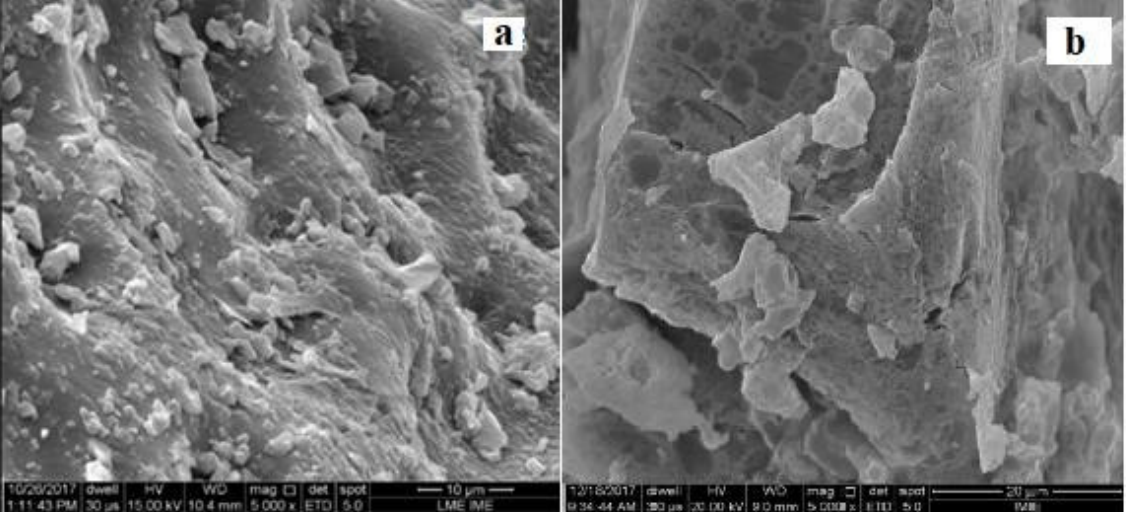
Figure 4. ( a ) Microscopy of açaí seed in nature at 5000× magnification. ( b ) Microscopy of açaí seed impregnated with NaOH at 5000× magnification. impregnated with NaOH at 5000 × magnification.